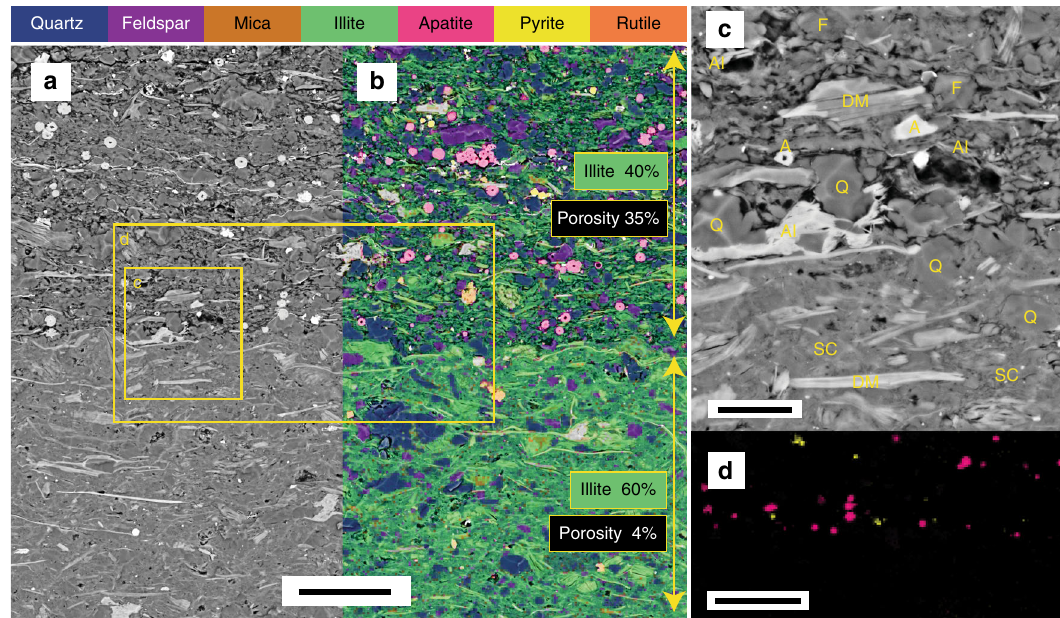
Fig. 2 SEM backscatter image with Nanomin overlay of two laminae from McManus-1. a SEM backscatter image revealing textural difference and highlighting porosity (35% of image area) in the upper laminae vs. the occluded porosity (4% of image area) in the lower image. Grain size of detrital material is similar, but diagenetic pyrite and apatite are con fi ned to the uncemented laminae. Scale bar = 40 μ m. b Nanomin mineral map overlain on the continuation of the image in a to reveal the mineralogy showing 40% illite in the upper laminae vs. 60% illite present as interstitial quartz and illite cement in the lower laminae. c Detail of the contact between the laminae within box c reveals that the primary intergranular porosity in the upper laminae is largely preserved except in some areas where it is fi lled by minor authigenic clay crystals, apatite (A) and pyrite. Porosity in the lower lamiae is largely occluded by illite and silica (chert) cement (SC). Secondary mouldic porosity resulting from the dissolution of feldspar (F) in the cemented laminae postdates formation of cement with subsequent growth of authigenic illite (AI) within it. (DM detrital mica, Q quartz). Scale bar = 10 μ m. d Mineral map of only apatite and euhedral pyrite with no underlying BSE layer identi fi es these minerals are limited to the open porosity laminae and implies a later timing of formation following the reduction of porosity in the lower laminae. Scale bar = 40 μ